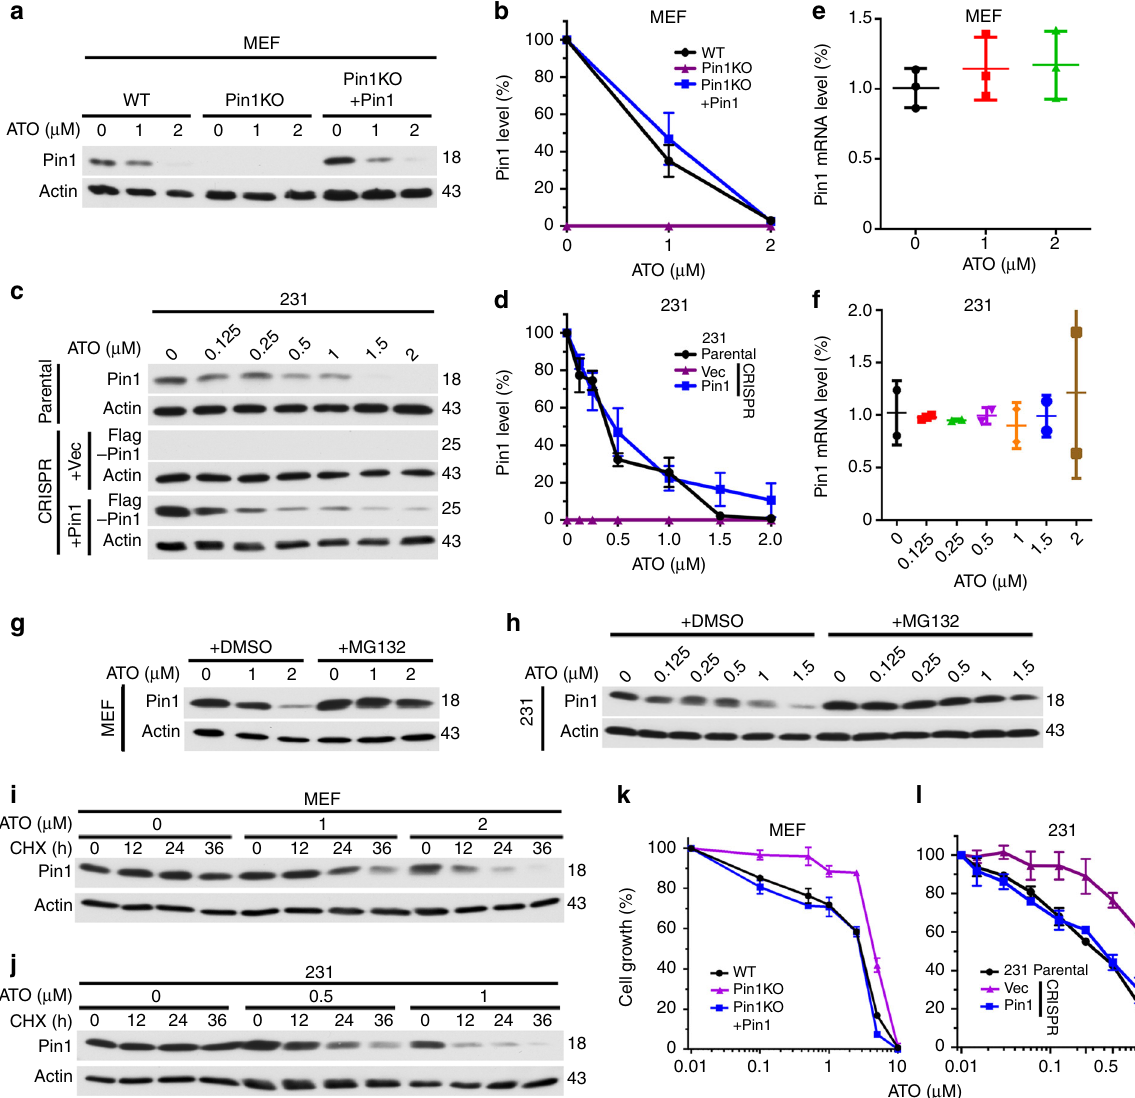
Fig. 1 ATO induces Pin1 degradation and inhibits cell growth at clinically relevant concentrations. a – d ATO dose-dependently reduces Pin1 in MEFs ( a , b ) and 231 cells ( c , d ). Pin1 WT and KO MEFs or 231 cells, or Pin1 KO MEFs or 231 cells reconstituted with Pin1 were treated with different